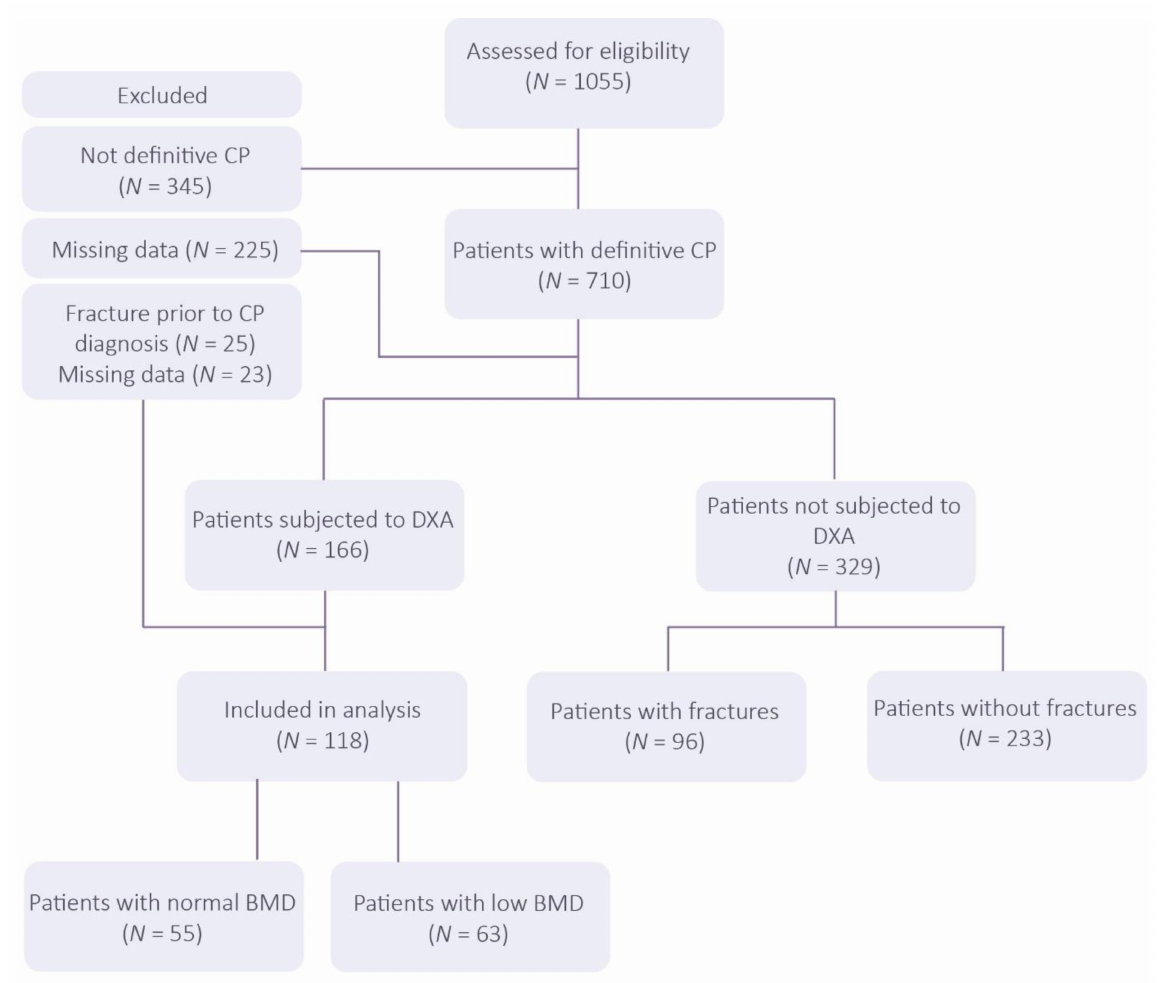
Figure 1. Flow chart of patient selection (CP = chronic pancreatitis; BMD = bone mineral density; DXA = dual-energy X-ray